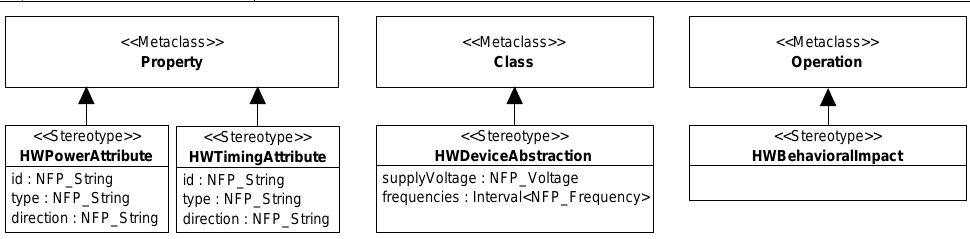
Figure 8. PAP HardwareAbstraction sub-profile package, adapted from [15] (UML 2.5 profile diagram